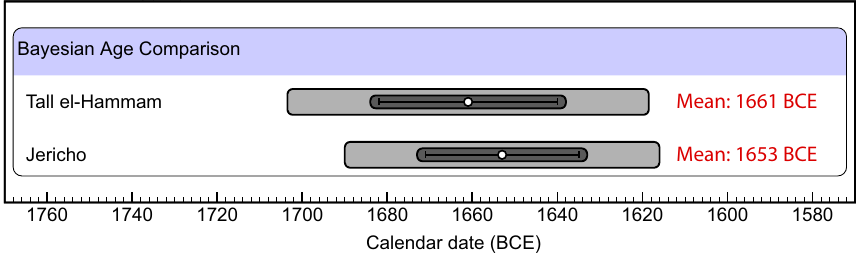
Figure 50. Comparison of Dates of MBA Destruction of Jericho and TeH. Bayesian calculation showing essentially identical age ranges at 68% Confidence Interval for the destruction layers of the two cities. For TeH, the range is 1686–1632 BCE (1661 ± 21 BCE) and for Jericho 1670–1626 years BCE (1653 ± 18 BCE), for a common overlap of 38 years, making them statistically